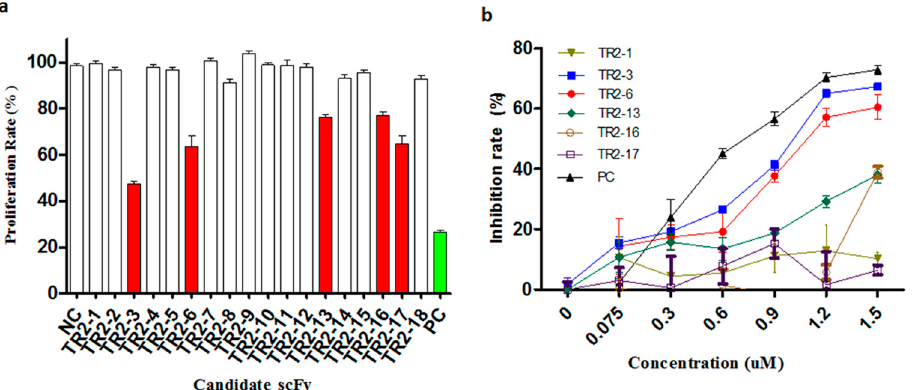
Figure 2. Identification of agonistic anti-DR5 scFv in the cell viability assay. ( a ) Anti-proliferative effect of periplasmic scFv extracts was investigated in a high-throughput 3-(4,5-dimethylthiazol-2-yl)-2,5-diphenyl tetrazolium bromide (MTT) assay on COLO205 cells. Putative agonistic anti-death receptor 5 (DR5) scFv were selected as those that significantly inhibited the COLO205 cells proliferation relative to negative controls (NC). All 18 anti-DR5 scFv were tested and five putative agonistic anti-DR5 scFv antibodies were selected for further study (red bars); The scFv format of Apomab was used as a positive control (PC, green bar). ( b ) After purification of these scFv proteins, the agonistic anti-DR5 scFv was identified by the MTT assay on COLO205 cells. The scFv format of Apomab was included in the same assay as a positive control (PC). These data are representative of at least three independent experiments.